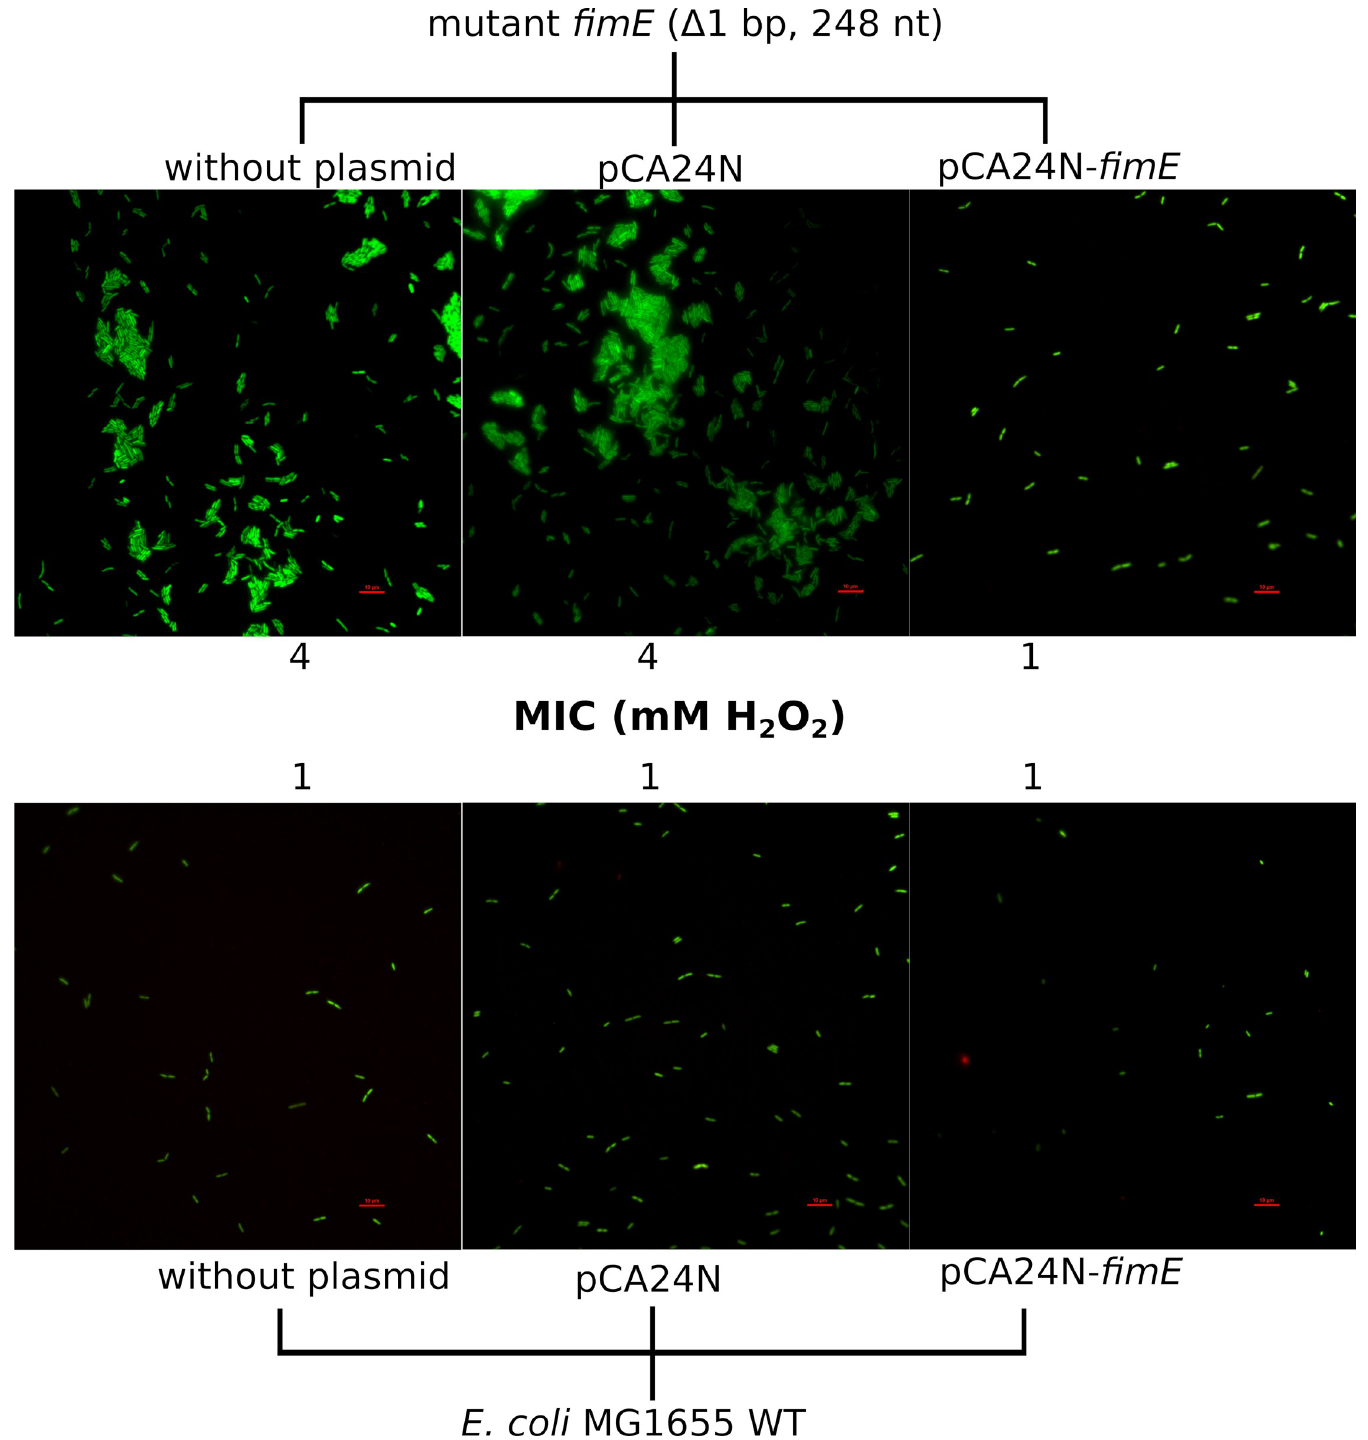
Fig 9. Representative fluorescent micrographs of attachment to a glass slide by E . coli MG1655 and its derivative mutant fimE ( Δ 1 bp, position 248 out of 597 nucleotides). The image was taken after vital staining (LIVE/DEAD BacLight Bacterial Viability Kit). Top panel shows greater attachment and reduced sensitivity to H 2 O 2 MIC associated with fimE inactivation. Complementation restores both H 2 O 2 sensitivity and the low-attachment phenotype of the wild-type strain (lower panel). In both panels control cells (transformed with the cloning vector pCA24N) can be also observed.